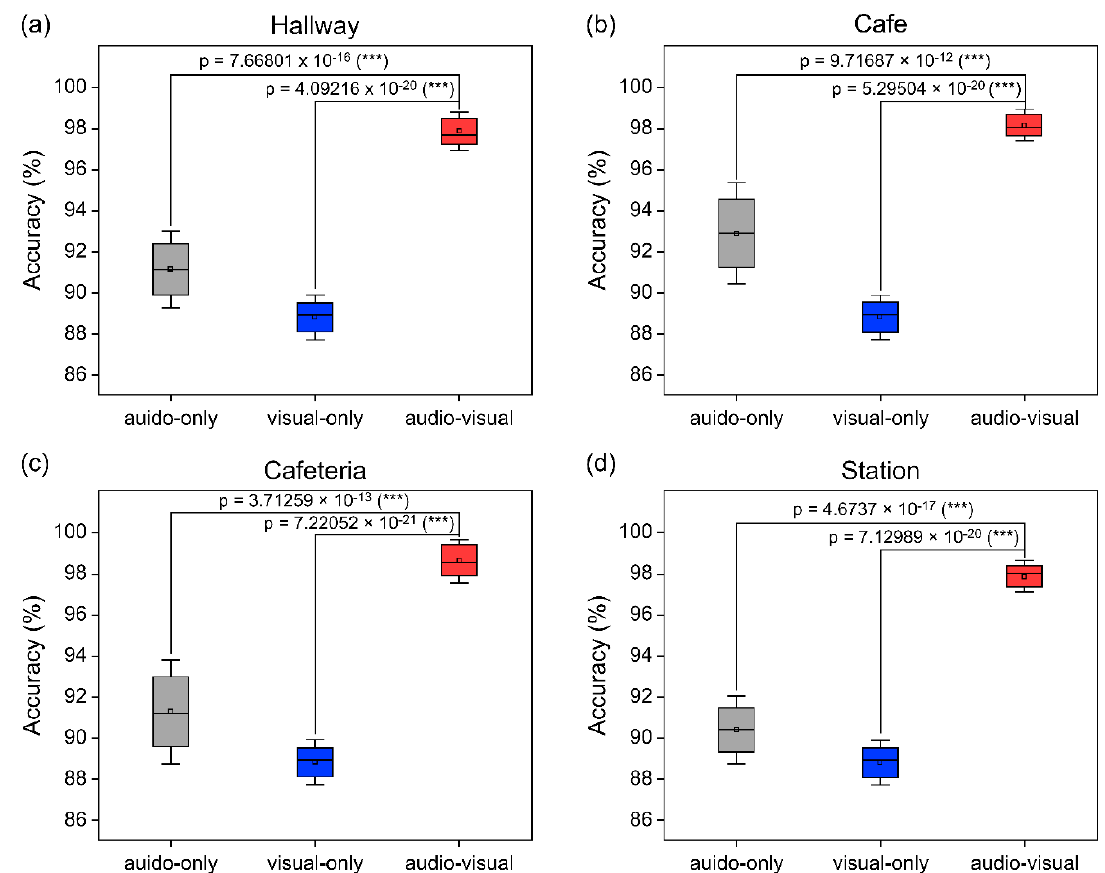
Figure 15. Average recognition accuracy rates in four noisy scenarios. The error bars show the standard deviation. t -tests with statistical significance between each group are indicated by asterisks (* for p < 0.05, ** for p < 0.01, *** for p < 0.001). The gray (single-modal recognition), blue (single-modal recognition), and red (multimodal recognition) boxes show the results of auditory-only, visual-only, and audiovisual recognition, respectively.